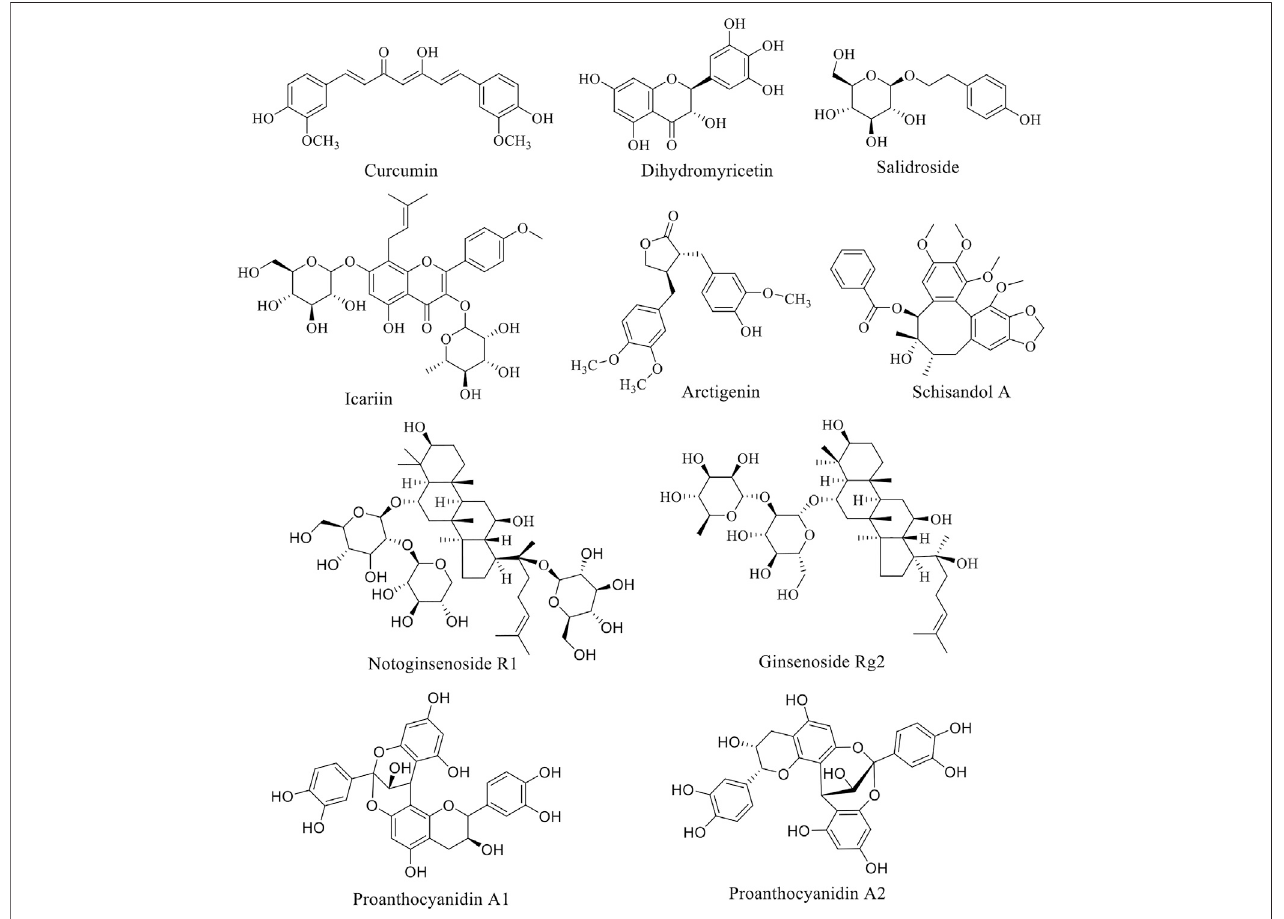
FIGURE 1 | Structure of anti-PD natural